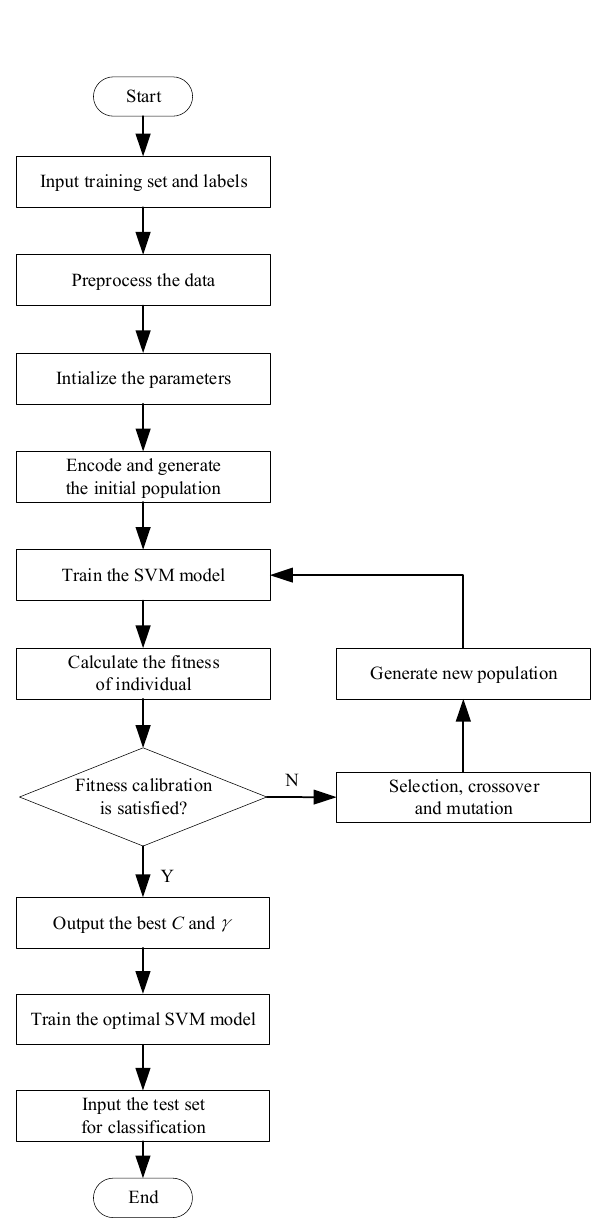
Figure 2. The complete flow of the GA–SVM. The core of the GA–SVM is using genetic algorithm to simulate the rule of the fittest survives, and the unsuitable are eliminated in nature, so as to search the best penalty coefficient and the kernel parameter. Ultimately, the optimal SVM model is formed.